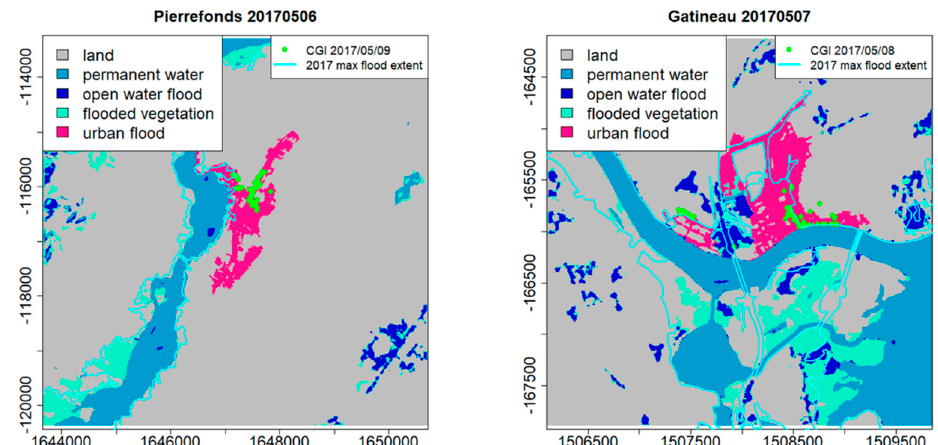
Figure 9. Urban flood extents generated using LidarDEM and CGI data collected May 9, 2017 in Pierrefonds on an EGS RS2 flood map from May 6, 2017 ( left ), and May 8, 2017 in Gatineau on an EGS RS2 flood map from May 7, 2017 ( right ).